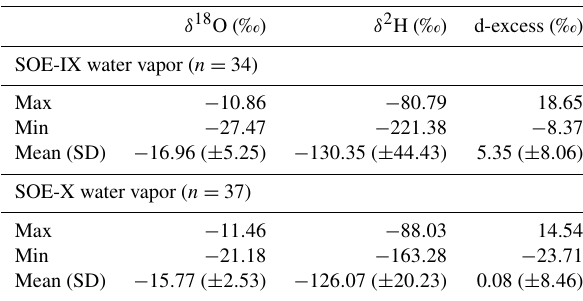
Table 1. Descriptive statistics of the water vapor isotopic composi-